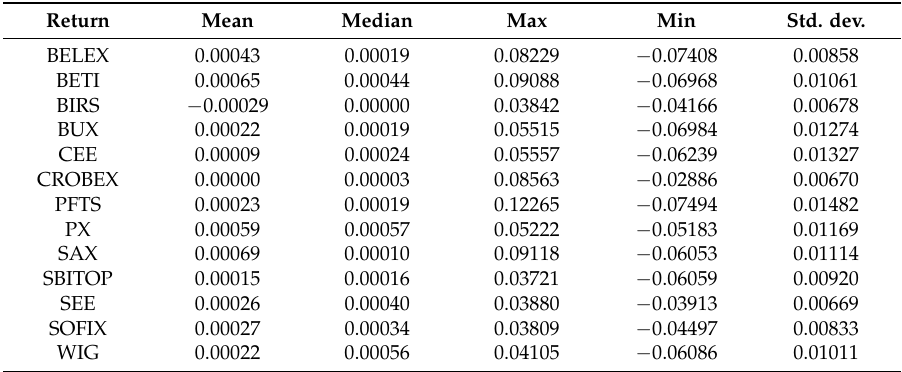
Figure A2. Individual CAR s, SEE regional market factor. Table A1. Descriptive statistics for return series.